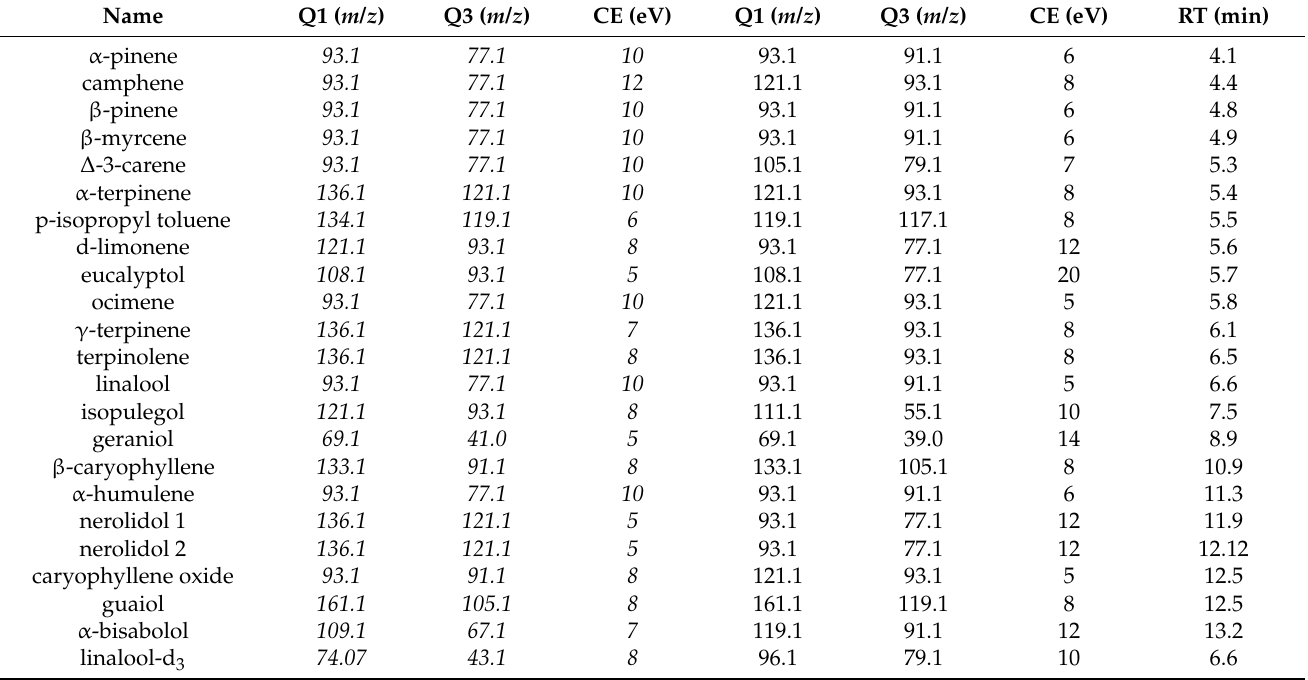
Table 7. Gas chromatography-tandem mass spectrometer acquisition parameters for